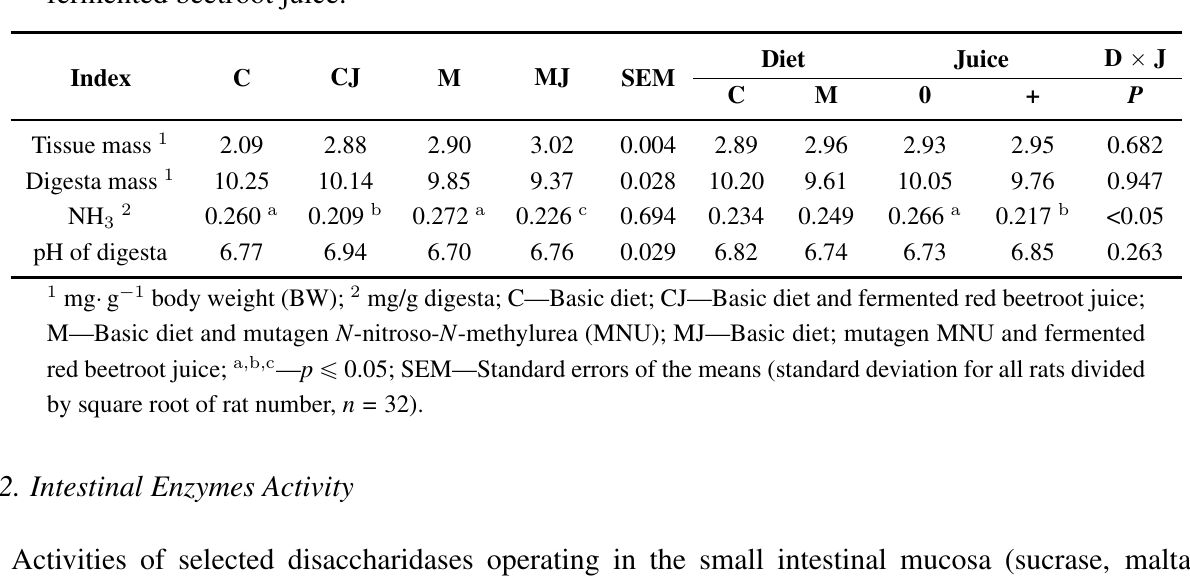
Table 1. Cecum parameters of rats were fed mutagen N -nitroso- N -methylurea (MNU) and fermented beetroot